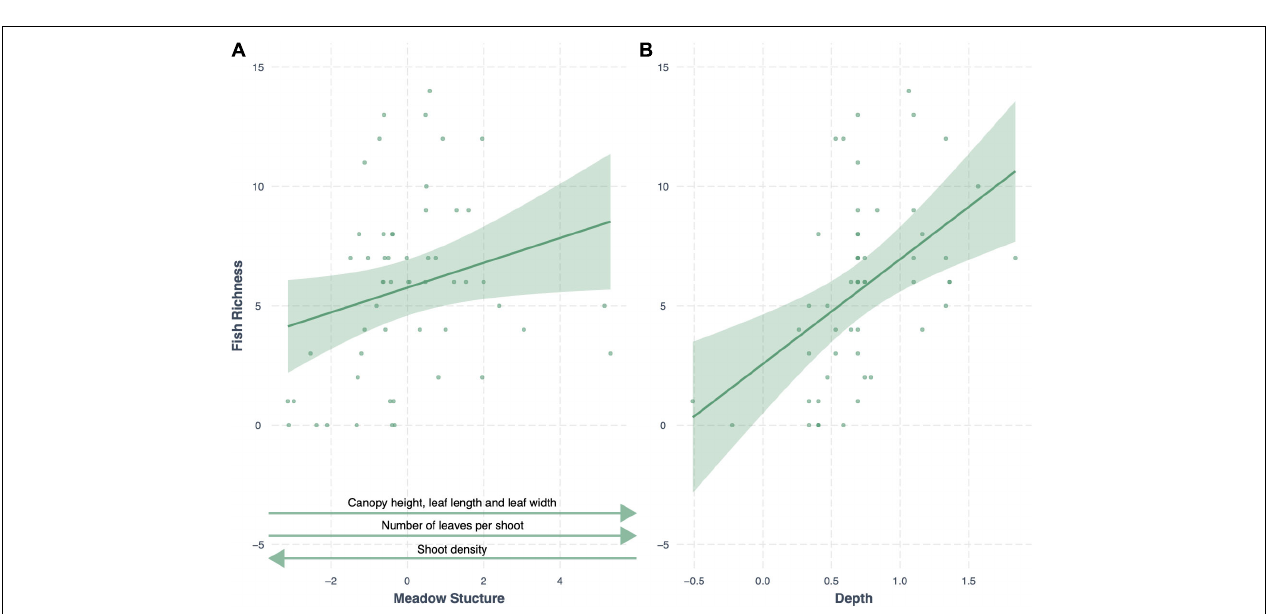
FIGURE 5 | Conditional effect plots for the second-best model predicting fish richness (R 2 = 0.42) in tropical seagrass meadows across 12 sites. Predictor variables include (A) meadow structure (inverse of PC1) and (B) log depth (m). Shaded areas represent 95% confidence intervals, reflecting the variance of the fixed effects.